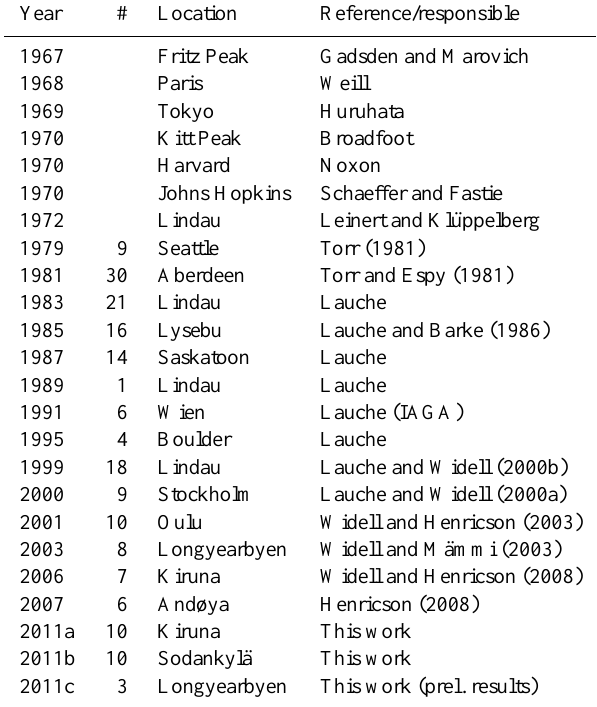
Table 1. Known official intercalibration workshops. The 1967– 1972 intercalibrations are mentioned by Torr (1983). Regarding later calibration workshops lacking a literature reference, the re- sults and raw data are archived by the corresponding author of this paper. Copies are available upon request. The column # refers to the number of participating calibration